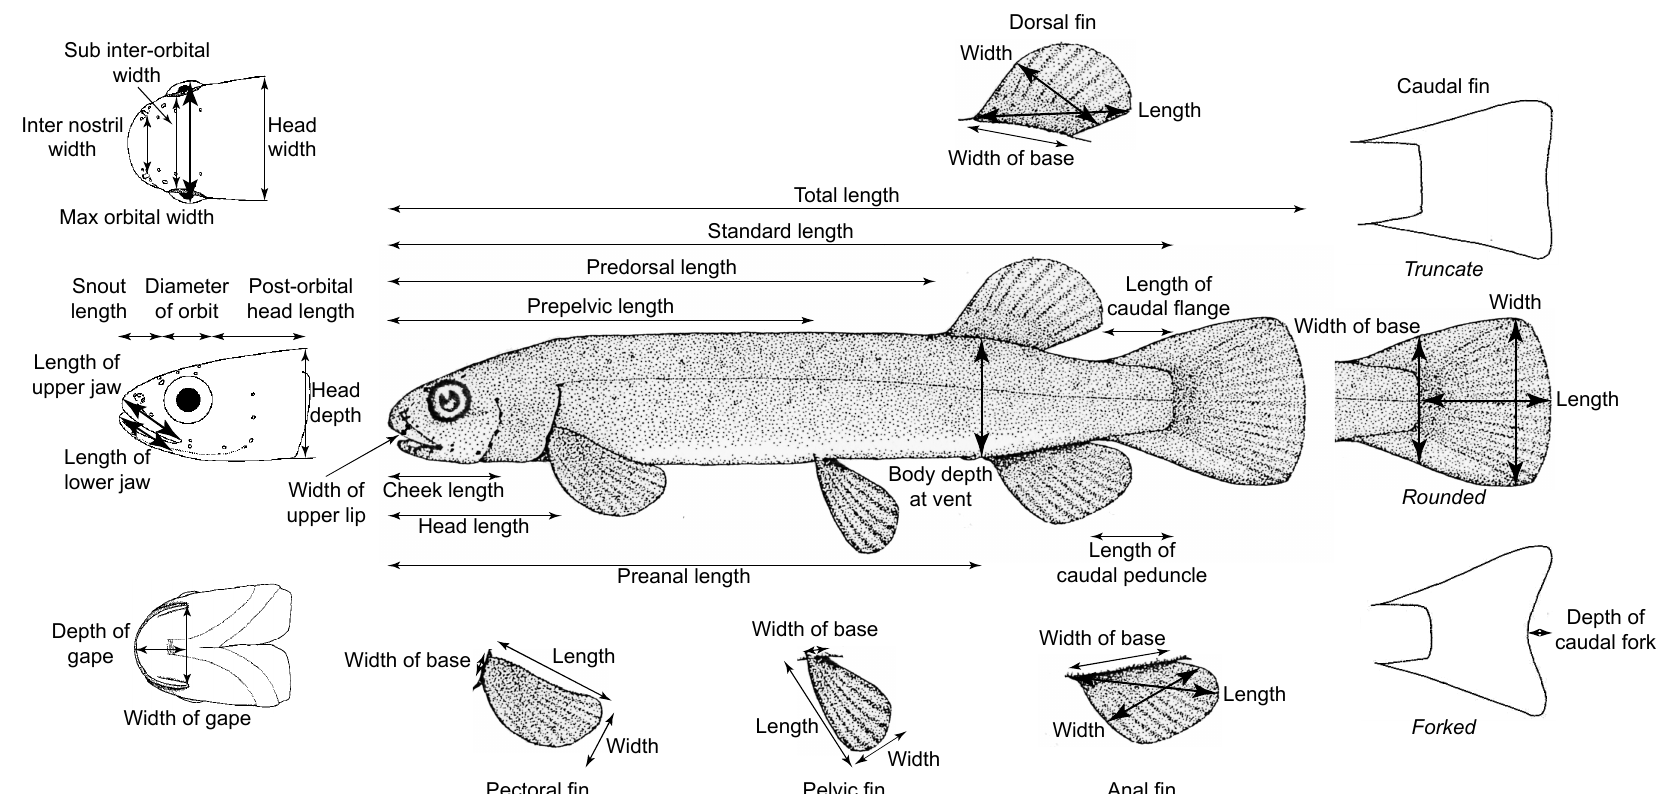
Figure 1. Morphological measures used to create ratios for further analyses. See text for further descriptions. Drawings modified from the originals by R. M. McDowall.